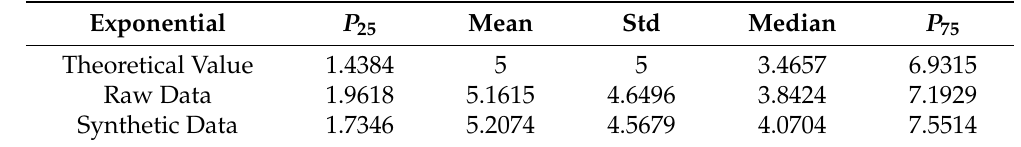
Table 3. Population parameters of Exponential distribution and their point estimates considering the raw data and synthetic data generated from those raw